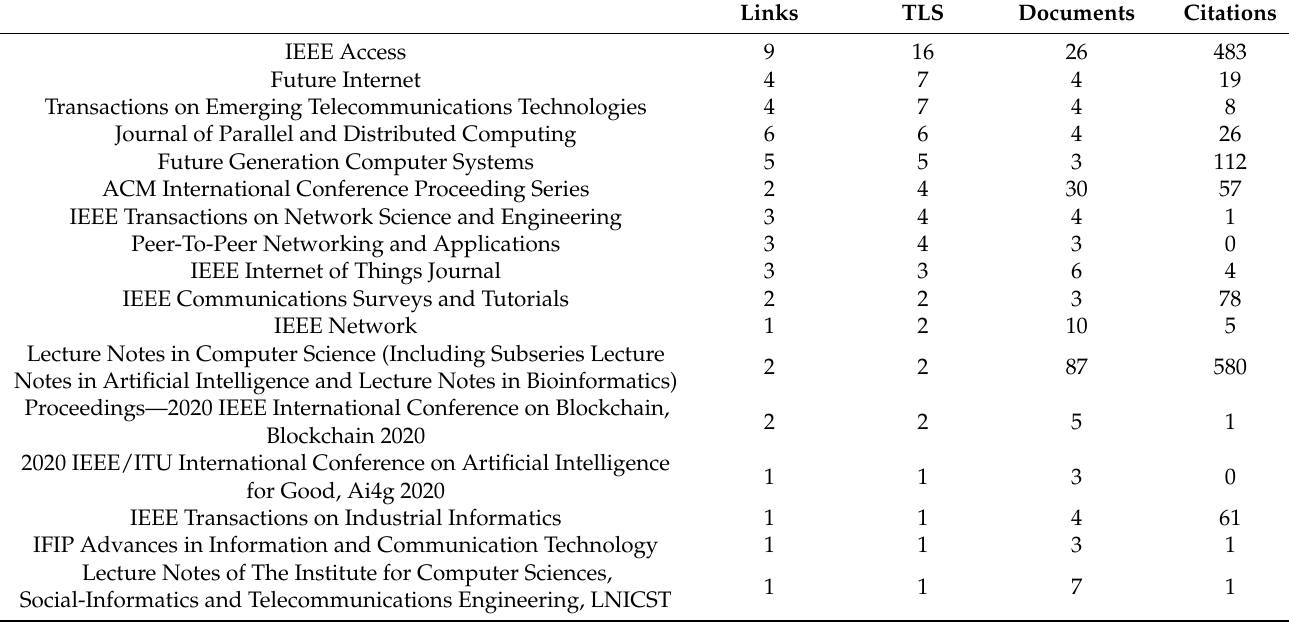
Table 12. Links, TLS, Documents and Citations for Citation Analysis (Authors).